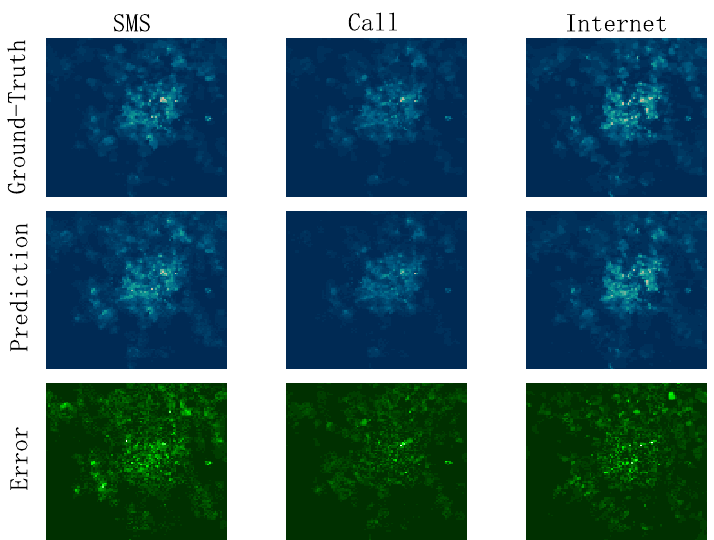
Figure 11. Comparison of hourly traffic prediction with the ground truth.